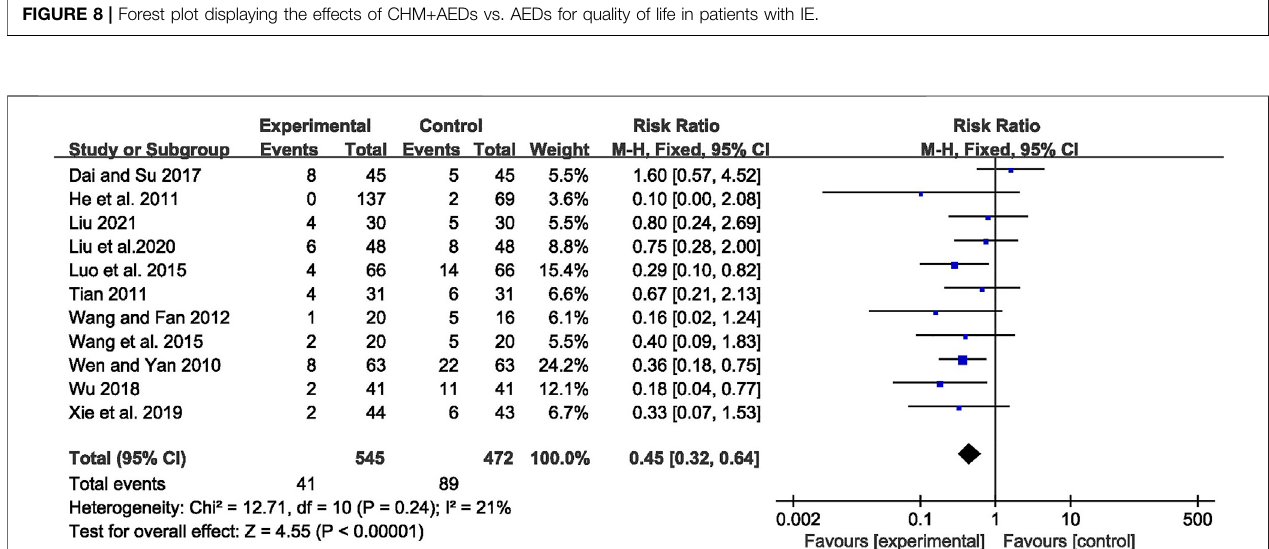
FIGURE 8 | Forest plot displaying the effects of CHM+AEDs vs. AEDs for quality of life in patients with IE.